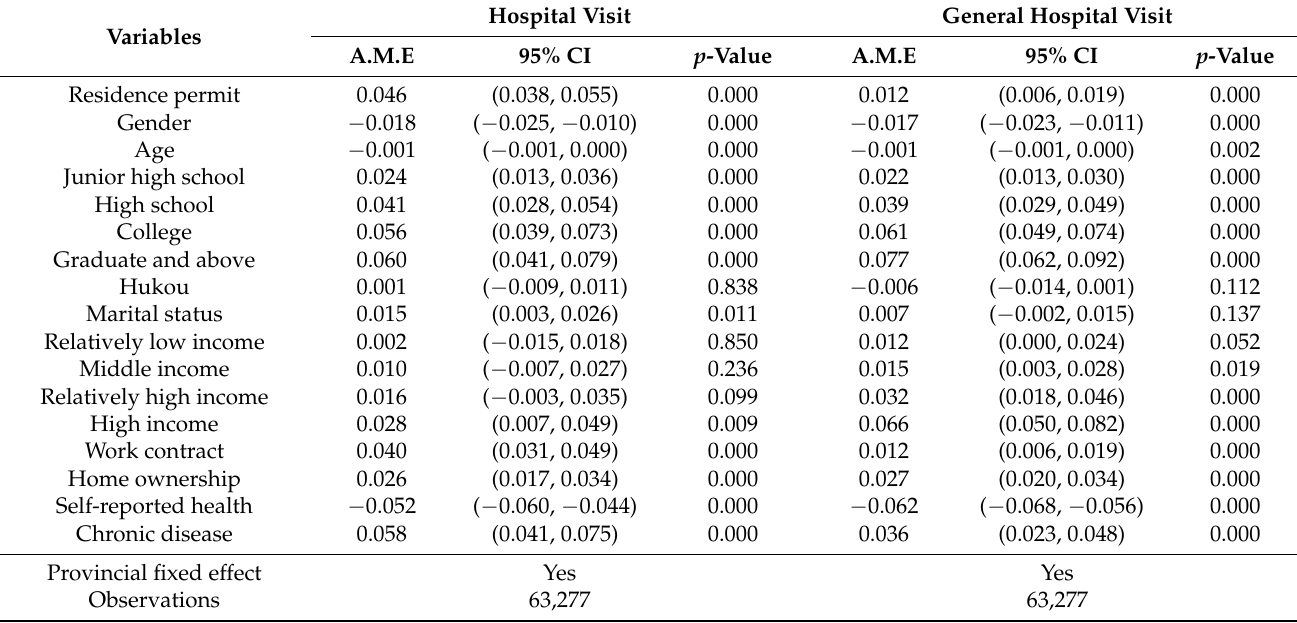
Table 3. Average marginal effects of residence permit on the utilization of public medical